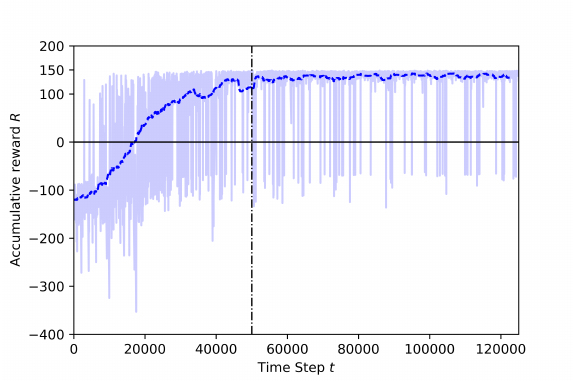
Figure 18. Training result for Case